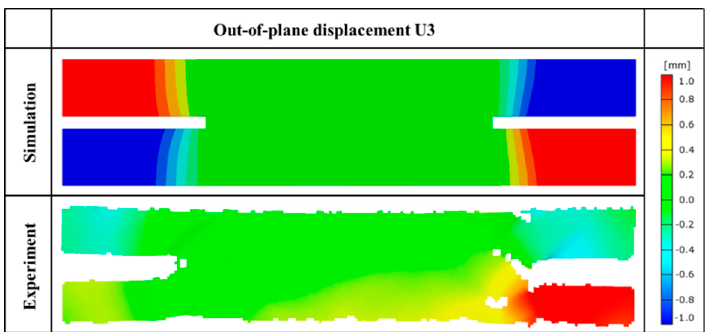
Figure 5. Comparison of numerical predicted and experimental measured out-of-plane displacement contours of notched tension specimen.